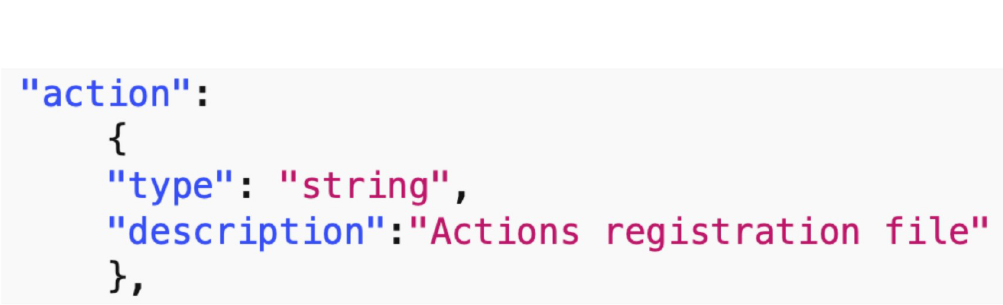
PLOS ONE | https://doi.org/10.1371/journal.pone.0242453 November24,